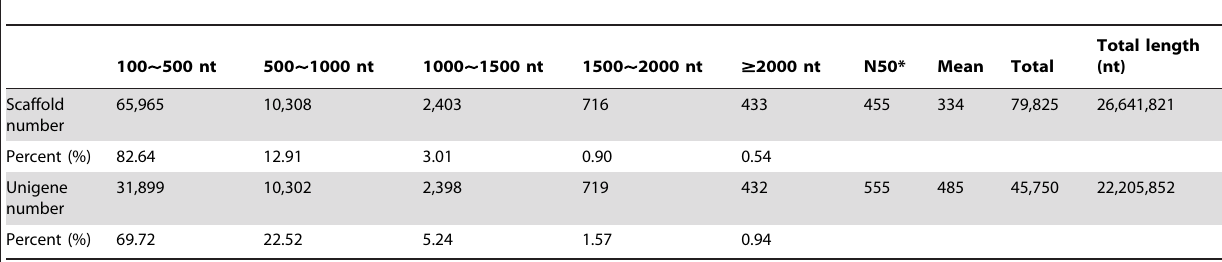
Table 2. The scaffold and unigene assemble result of O. furnacalis transcriptome.